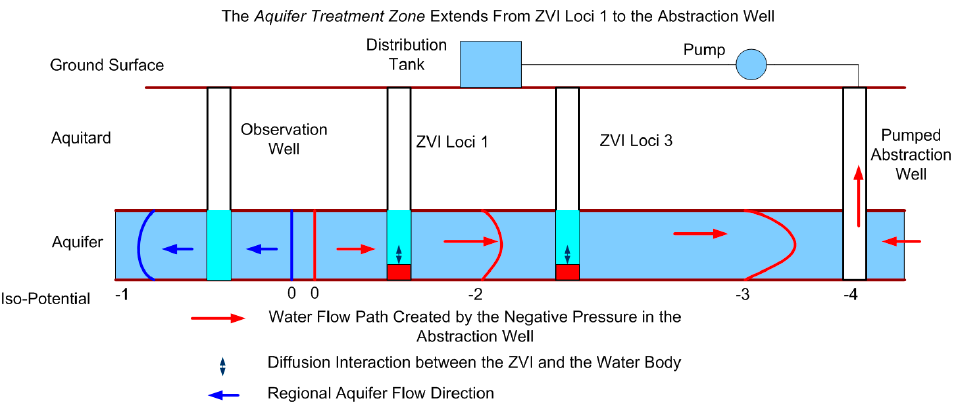
Figure C1. Cross-Section through a schematic Aquifer which has been reconfigured to produce partially desalinated water. ZVI pellets and cartridges are shown in red.